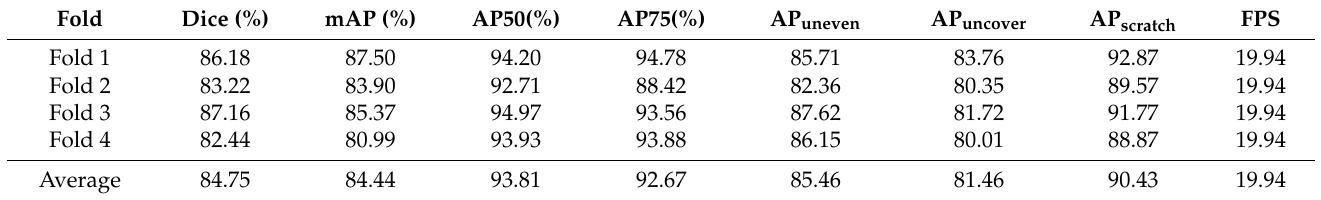
Table 9. Four-fold cross validation result, where FPS denotes for frame per second by using the YOLACT model. In total, the number of parameters used is 43,286,432.